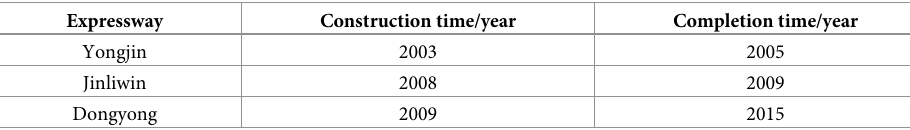
Table 1. Construction and completion time and length of each